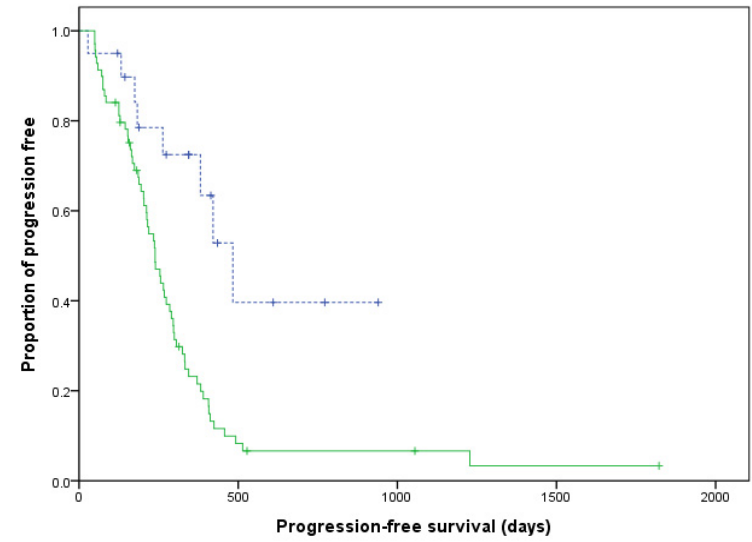
Figure 1. Kaplan–Meier curves of the progression-free survival duration for dogs with lymphoma. Dogs that received the LHOP chemotherapy are indicated by a dashed line, whereas dogs that re-